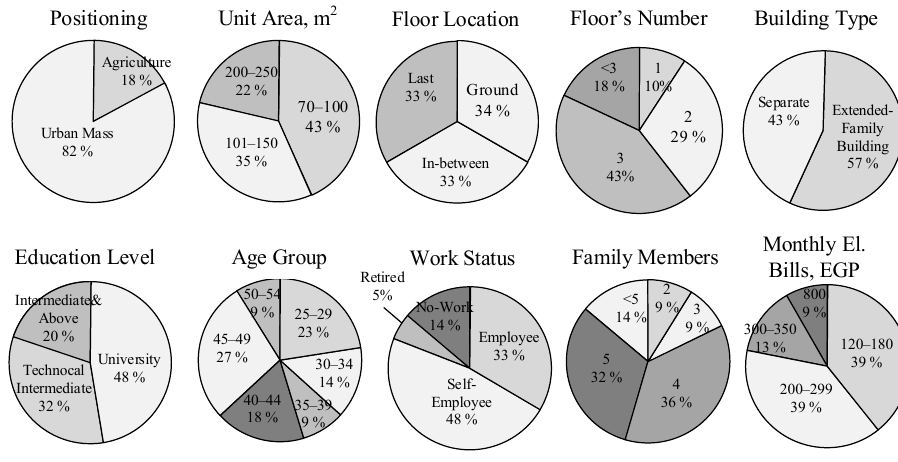
Fig. 7. The results of respondents’ characteristics and their dwellings' patterns.